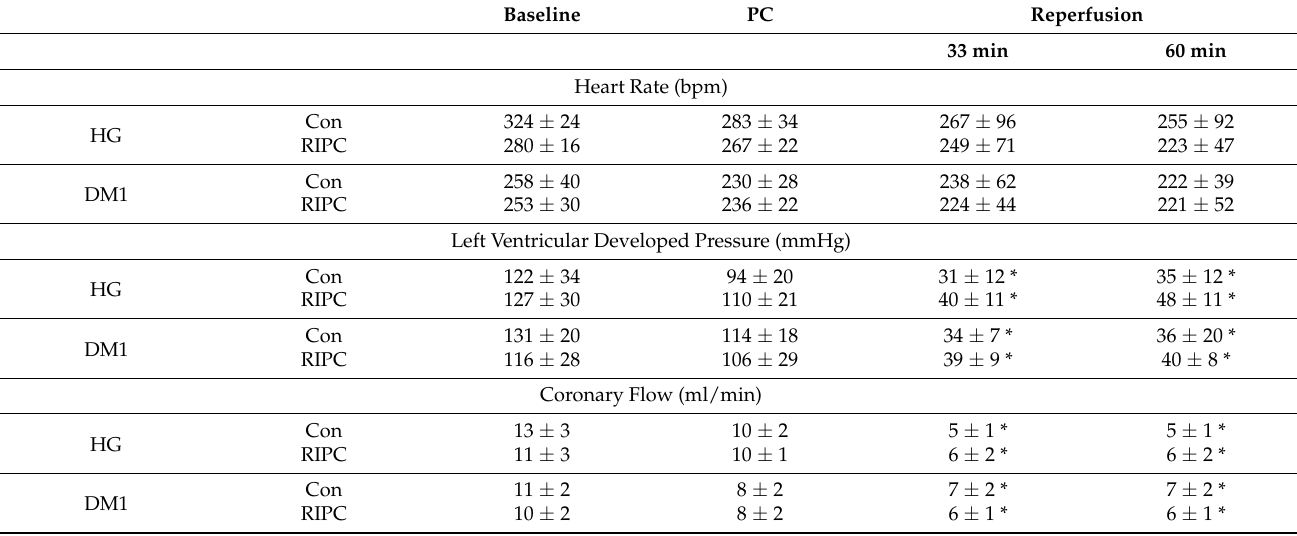
Table 3. Hemodynamic variables from part 2 (plasma transfer healthy →